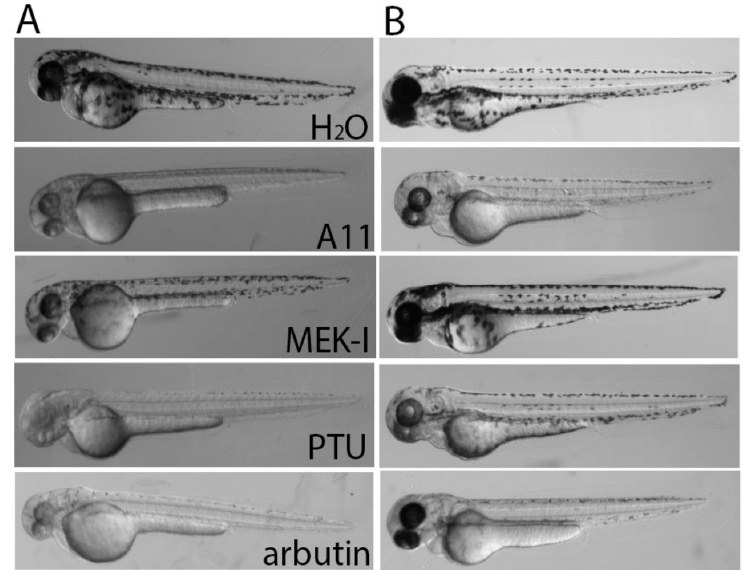
Figure 5. Slow pigment recovery by A11. Embryos were treated with skin-lightening compounds from 24–72 hpf ( A ) then washed with egg water twice and allowed to develop until 96 hpf ( B ) in water to test how quickly pigment recovers after compound withdrawal. Most embryos recovered their pigment quickly except for A11 and arbutin.